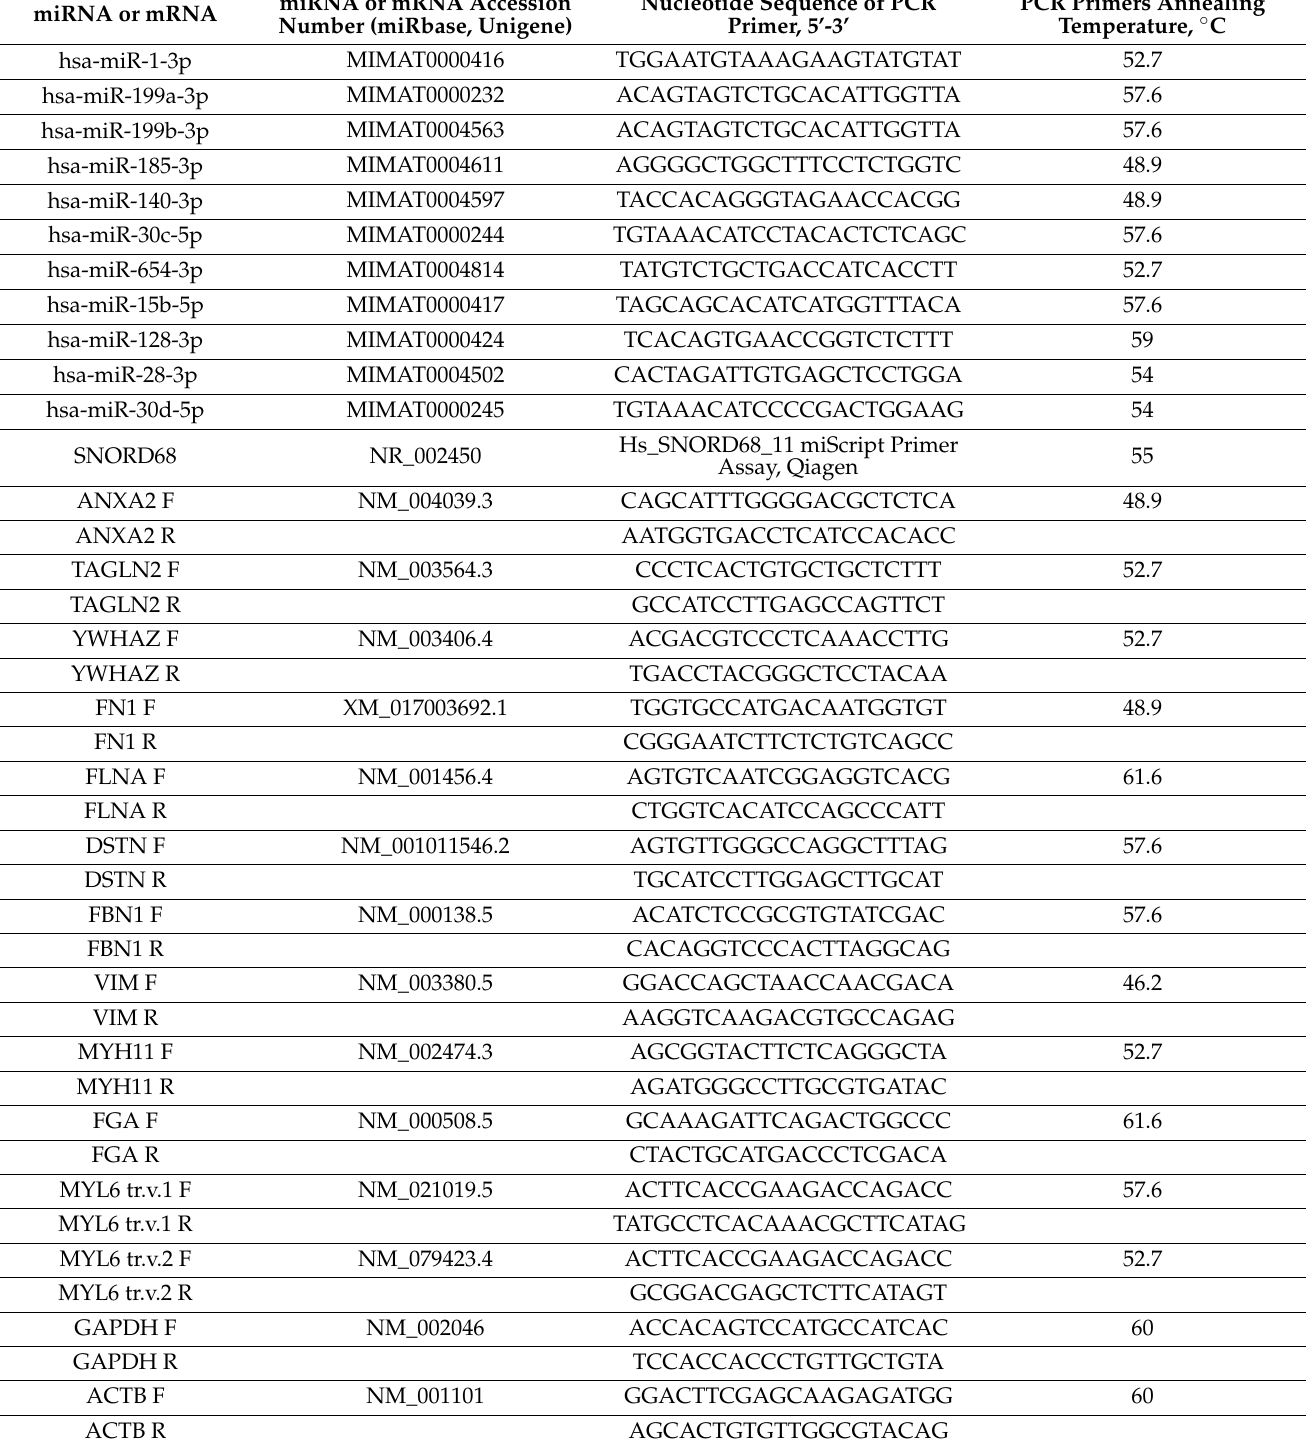
Table 6. miRNA and mRNA sequence